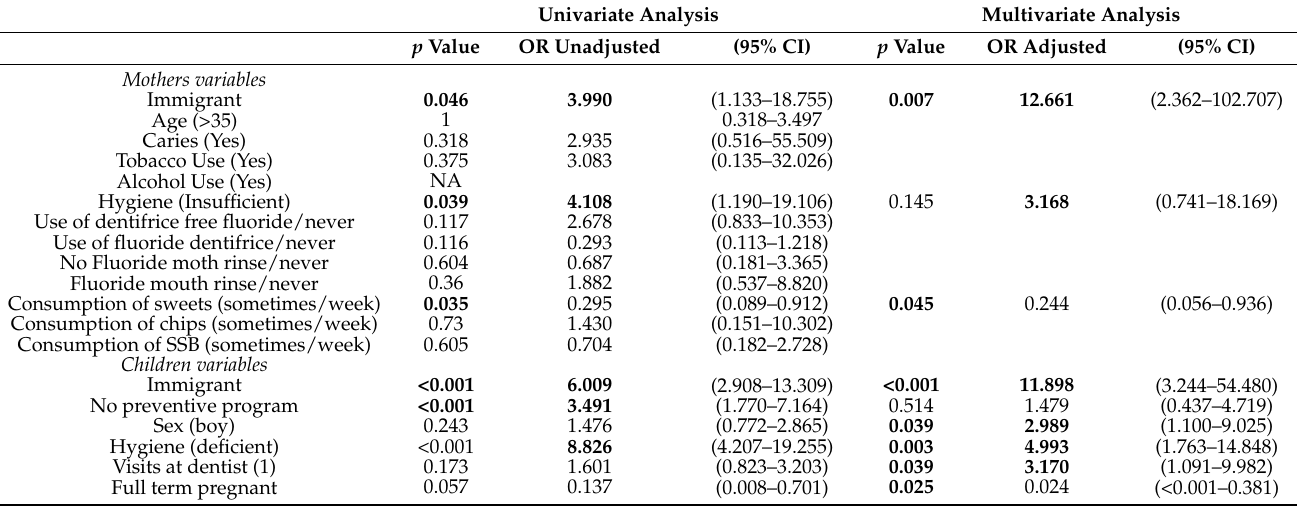
Table 4. Caries risk of immigrant and native children according to the variables considered for the mothers and the child’s. Univariate and multivariate analysis. NA: not applicable. OR: odd ratio. CI: confidence interval. In bold letter, statistically significant p -values and valid